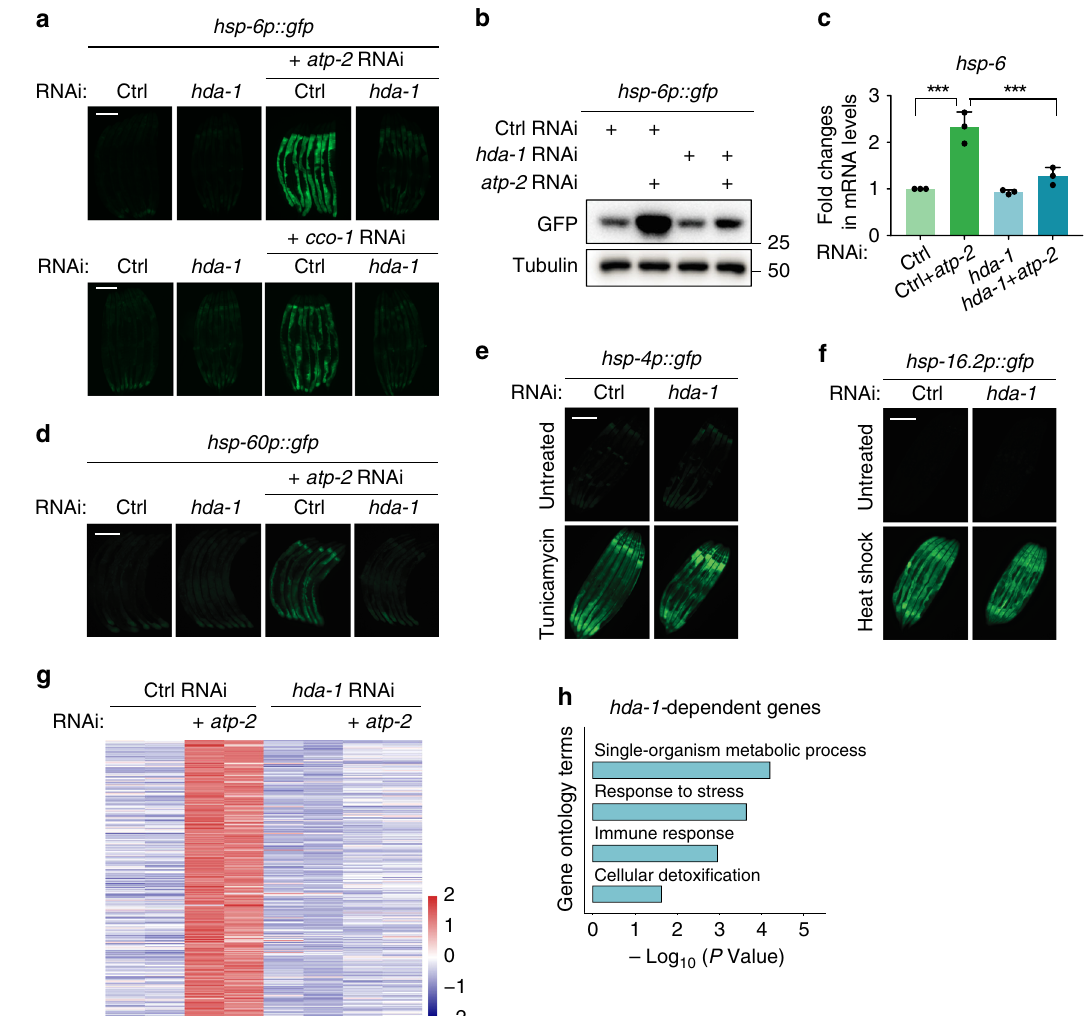
Fig. 1 hda-1 is required for UPR mt activation. a Representative fl uorescence images of hsp-6p::gfp worms. Worms on control (ctrl) or hda-1 RNAi were untreated or treated with atp-2 RNAi or cco-1 RNAi. Scale bar, 200 µ m. b Immunoblotting of GFP levels in hsp-6p::gfp worms. Tubulin serves as a loading control. c qRT-PCR measures endogenous transcript levels of hsp-6 in worms ( n = 3 independent experiments, n ≈ 1000 worms per sample). d Representative fl uorescence images of hsp-60p::gfp worms. Scale bar, 200 µ m. e Representative fl uorescence images of hsp-4p::gfp worms. Worms were fed with control or hda-1 RNAi and untreated or treated with tunicamycin. Scale bar, 200 µ m. f Representative fl uorescence images of hsp-16.2p::gfp worms. Worms on control or hda-1 RNAi were untreated or treated with heat shock. Scale bar, 200 µ m. g Heat map showing the expression pattern of 283 genes whose expression was upregulated under mitochondrial stress. Genes with an adjusted p value < 0.05 calculated by Cuffdiff were selected as differentially expressed genes. The heat map is scaled by row and colored according to the z-score. Genes with a higher expression level than the mean are colored red; genes with a lower expression level than the mean are colored blue. h Gene ontology (GO) term analysis of the 283 hda-1- dependent genes, whose expression levels were upregulated during UPR mt . Results in ( c ) are shown as mean + SD, and P values were calculated by one-way ANOVA and Tukey ’ s multiple comparisons test (*** P < 0.001). In ( h ), P values are DAVID modi fi ed Fisher exact P values, one-sided. Source data are provided as a Source Data fi